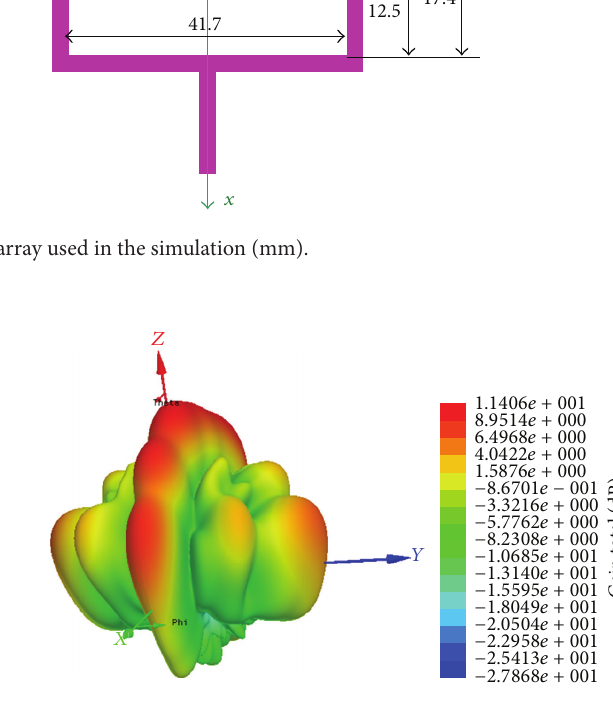
Figure 4: The 3D patterns of